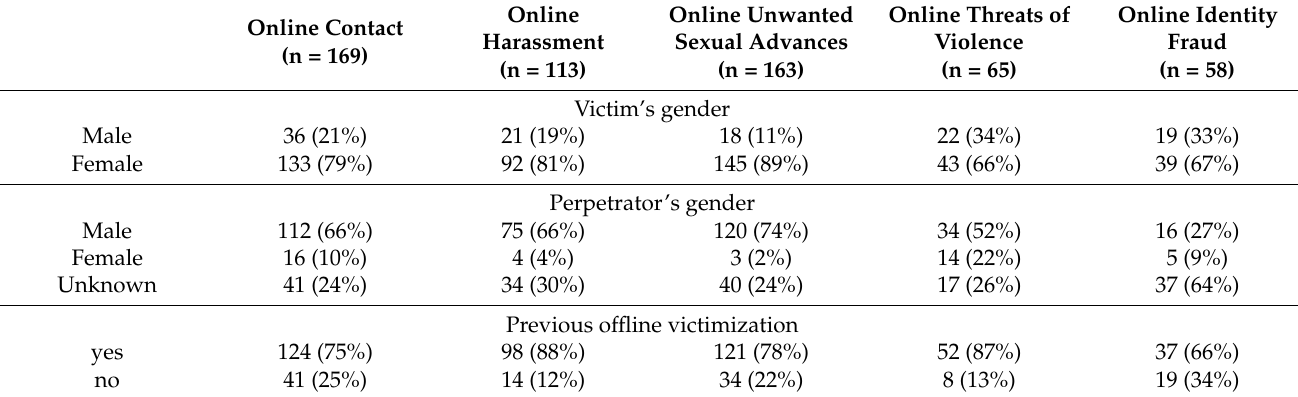
Table 1. Characteristics of the victims of cyberstalking (in parentheses value in percent).